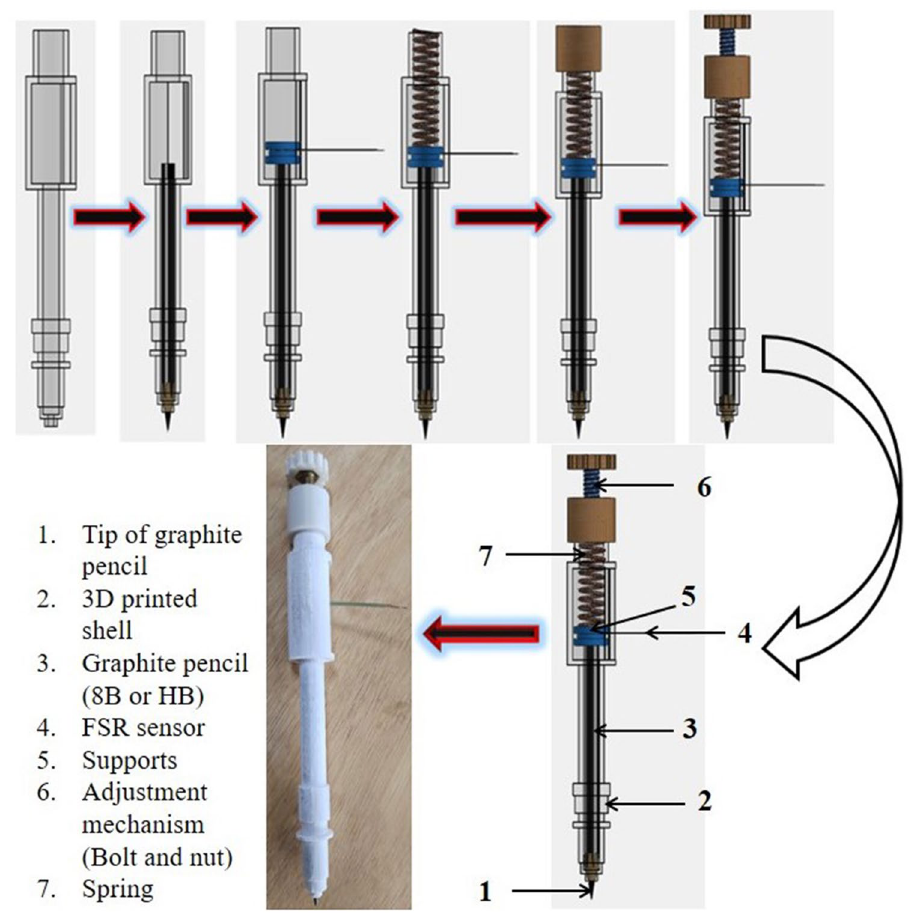
Figure 5. Detailed step-by-step fabrication procedure and a prototype model of automated pencil stroke device with FSR sensor.